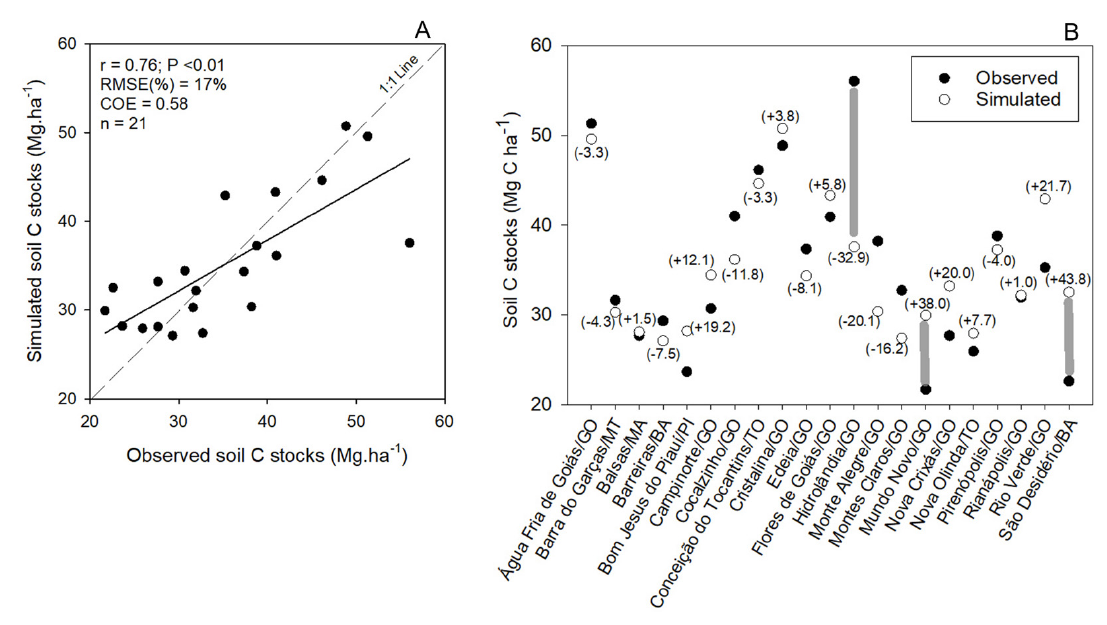
Figure 3. ( A ) Relationship between soil C (MgC · ha − 1 ) stocks (0–20 cm) observed in the field [21] and simulated by the CENTURY model for pasture areas in the Cerrado biome. ( B ) Soil C stocks (observed and simulated). Values in parentheses are the model error values in percentage. Gray bars indicate sites where errors were outside the ± 25% range.